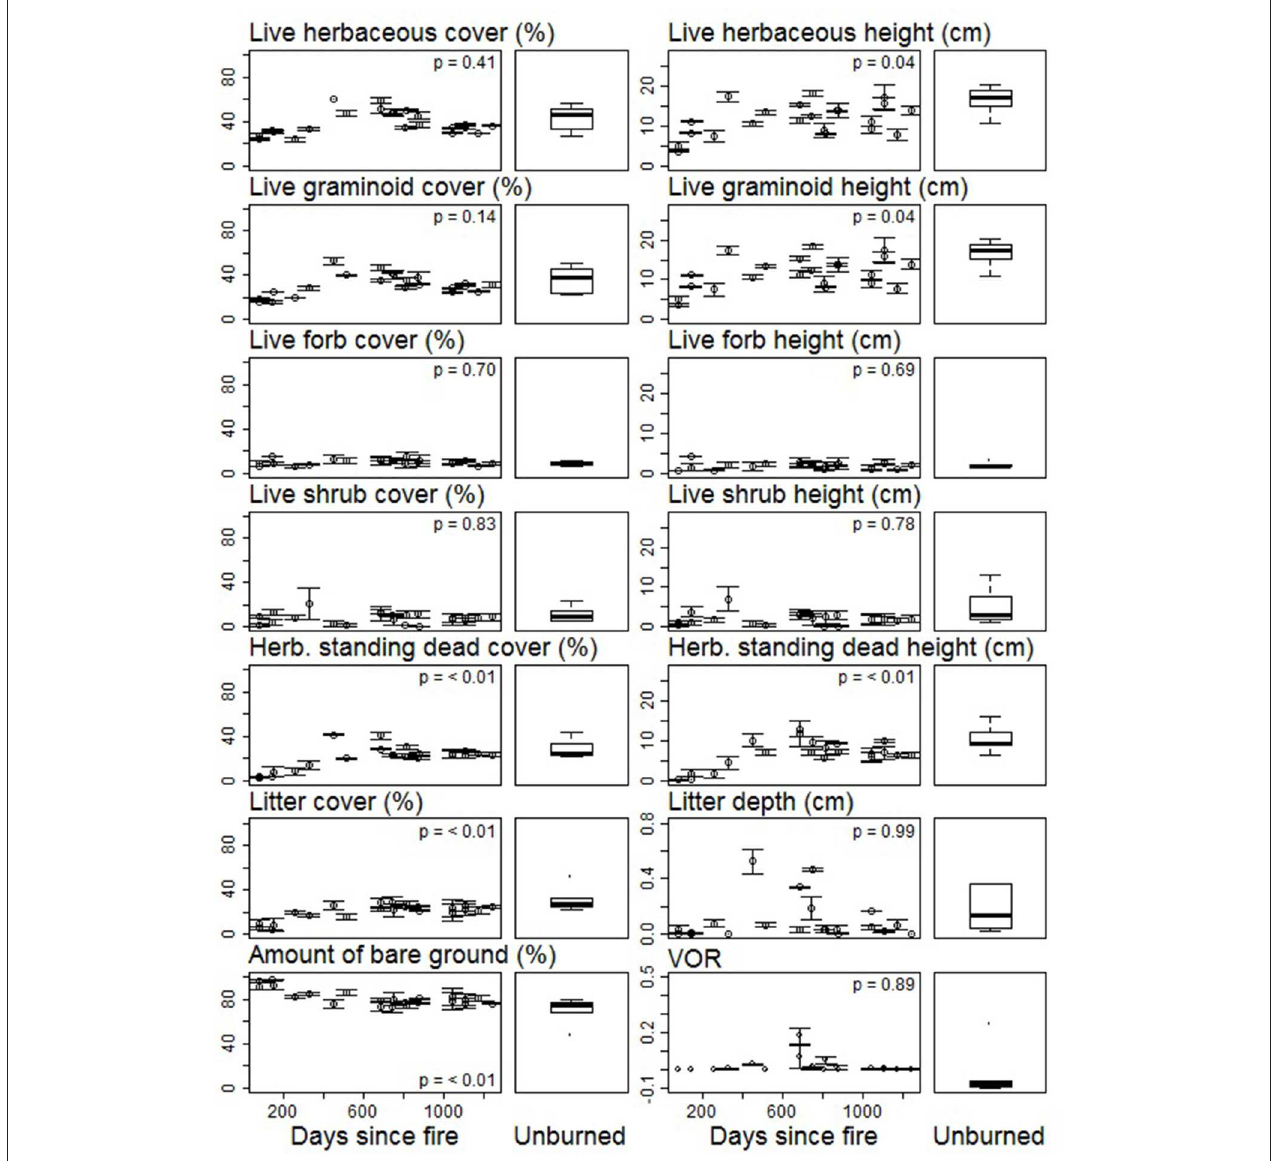
FIGURE 4 | Mean ( n = 2) and standard error of structural metrics [estimates of percentage foliar cover, litter cover, and bare ground; vegetation height and litter depth; and visual obstruction reading (VOR)] related to growing season vegetation following fire and grazing in the Nebraska Sandhills grassland.